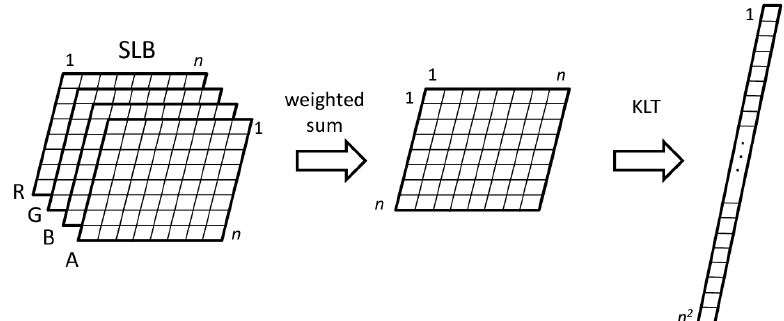
Figure 5. Steps involved in transforming subimage pixels into KLT coefficients.